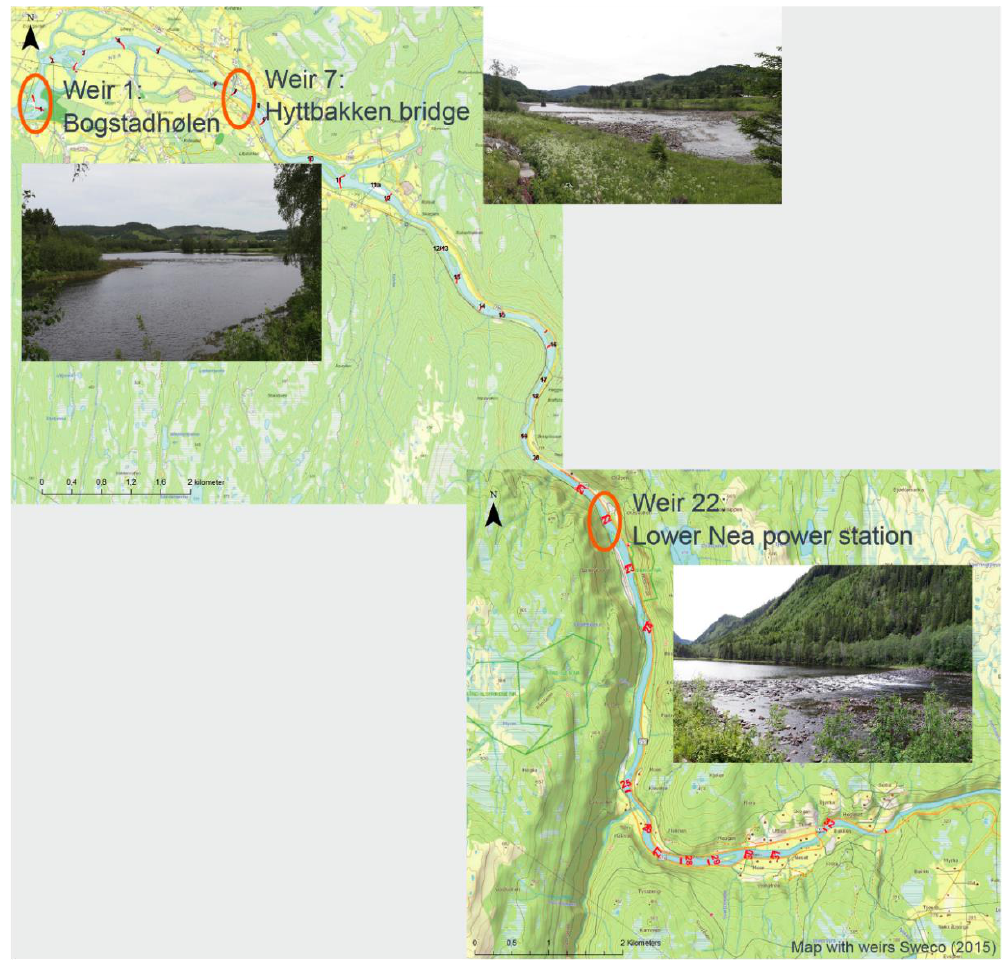
Figure 3. Site selection for the preference study. Weirs no. 1, 7, and 22 (outlined in orange) were selected to be visualized in environmental measure scenarios. Original images of the weirs are shown from the on-the-ground perspective © Sweco 2015.